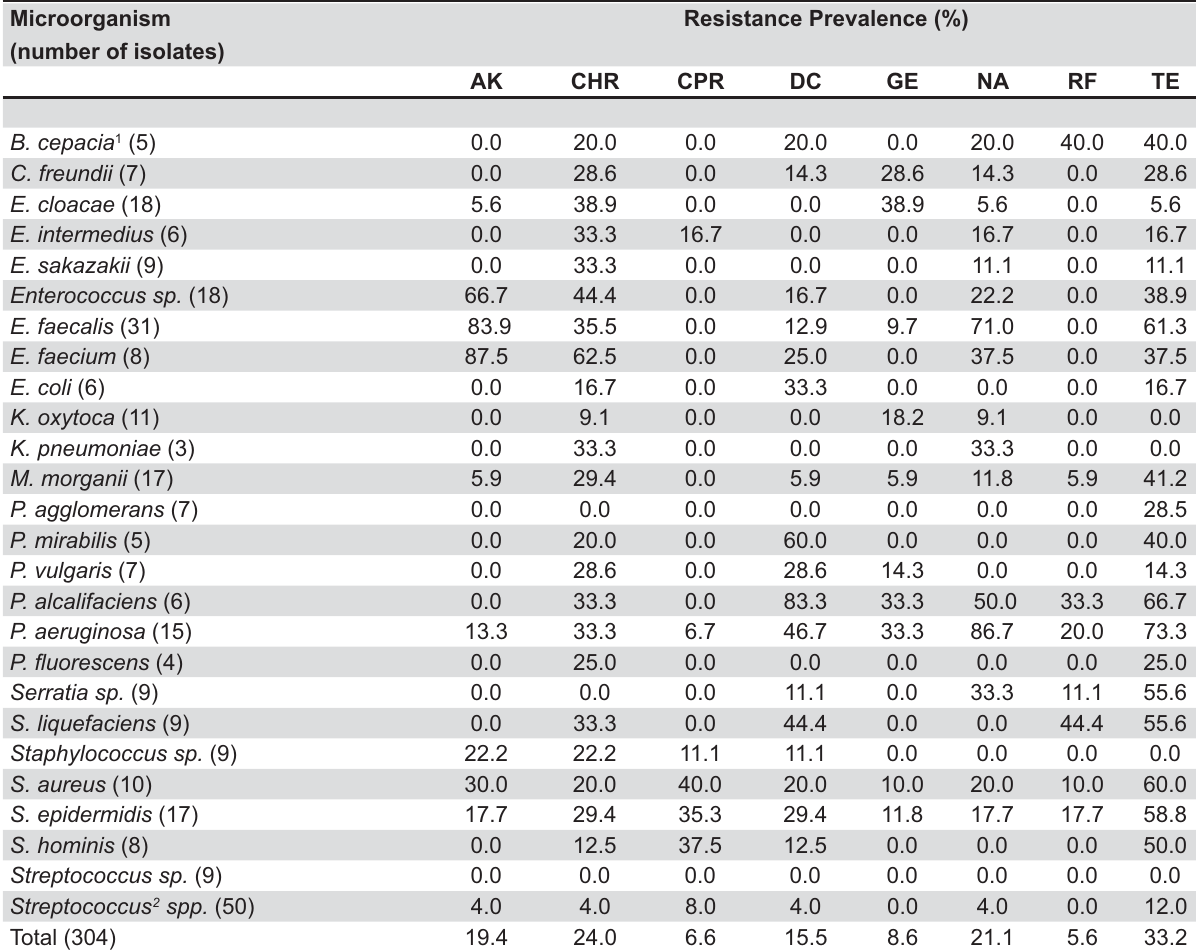
Table 3- (cid:2)(cid:26)(cid:20)(cid:5)(cid:10)(cid:4)(cid:23)(cid:7)(cid:6)(cid:18)(cid:6)(cid:14)(cid:6)(cid:7)(cid:22)(cid:2)(cid:11)(cid:16)(cid:2)(cid:7)(cid:27)(cid:4)(cid:2)(cid:6)(cid:5)(cid:11)(cid:14)(cid:8)(cid:7)(cid:4)(cid:5)(cid:2)(cid:7)(cid:11)(cid:2)(cid:8)(cid:15)(cid:6)(cid:28)(cid:8)(cid:10)(cid:6)(cid:9)(cid:29)(cid:2)(cid:10)(cid:27)(cid:14)(cid:11)(cid:17)(cid:8)(cid:15)(cid:23)(cid:27)(cid:4)(cid:9)(cid:6)(cid:10)(cid:11)(cid:14)(cid:29)(cid:2)(cid:10)(cid:6)(cid:23)(cid:17)(cid:11)(cid:30)(cid:11)(cid:31)(cid:8)(cid:10)(cid:6)(cid:9)(cid:29)(cid:2)(cid:19)(cid:11)(cid:31)(cid:22)(cid:10)(cid:22)(cid:10)(cid:14)(cid:6)(cid:9)(cid:4)(cid:29)(cid:2)(cid:25)(cid:4)(cid:9)(cid:7)(cid:8)(cid:15)(cid:6)(cid:10)(cid:6)(cid:9)(cid:29)(cid:2)(cid:9)(cid:8)(cid:14)(cid:6)(cid:19)(cid:6)(cid:31)(cid:6)(cid:10)(cid:2)(cid:8)(cid:10)(cid:6)(cid:19)(cid:29)(cid:2) rifampin, and